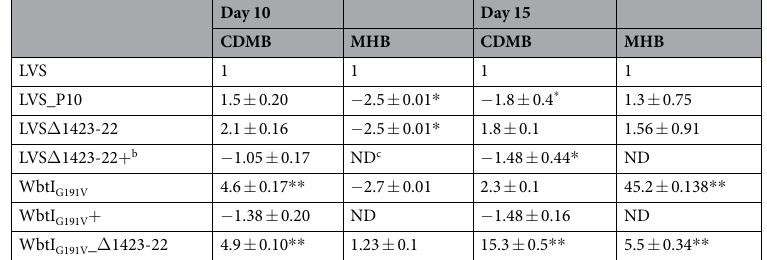
Table 2. Fold-difference in biofilm development a in CDM or MH compared to LVS. a Fold-difference calculated from OD560nm of CV assays. b + -strain with mutation complemented. c ND-Not determined. * Indicates P < 0.05; ** Indicates P <